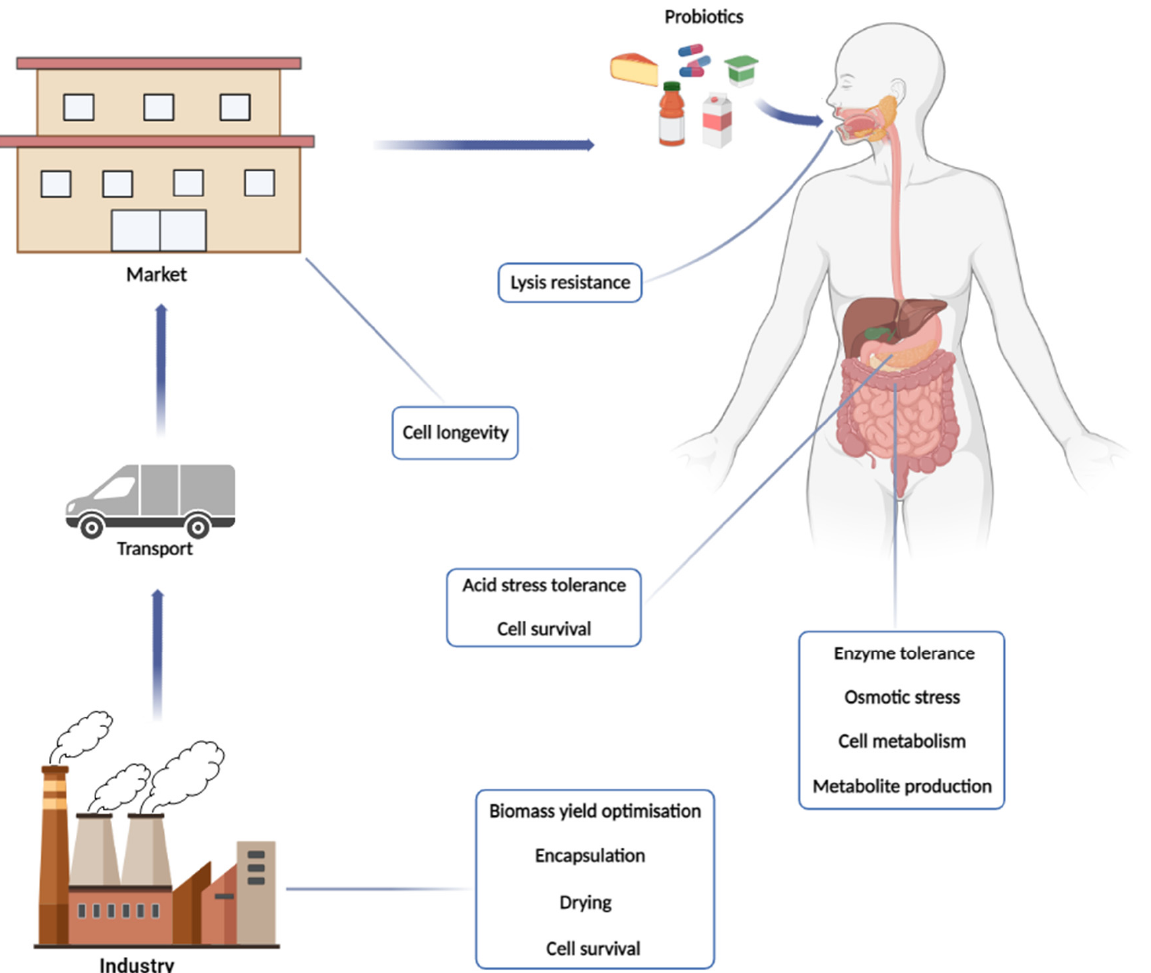
Figure 1. Journey of probiotic products from their production in the industry to their arrival in the intestine, where they will perform their beneficial functions for consumers. In this path, the main challenges and activities of the cells are highlighted.